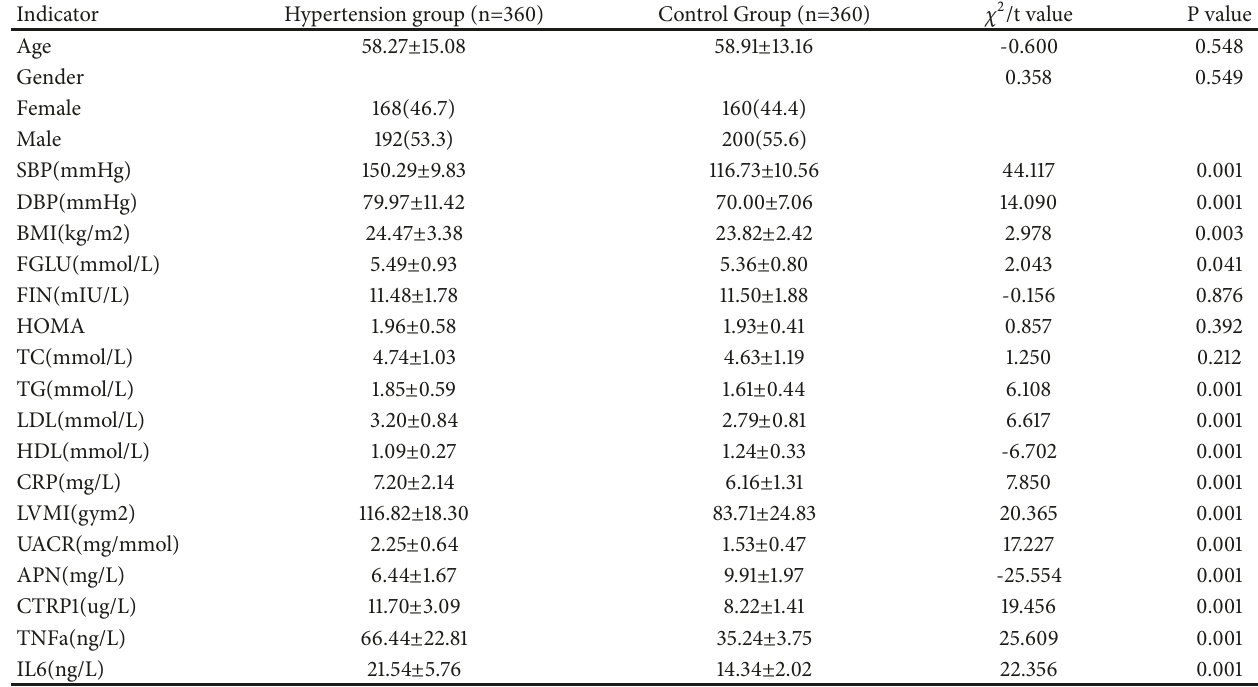
Table 1: Clinical and biochemical characteristics of hypertension group and control group (x ± s).